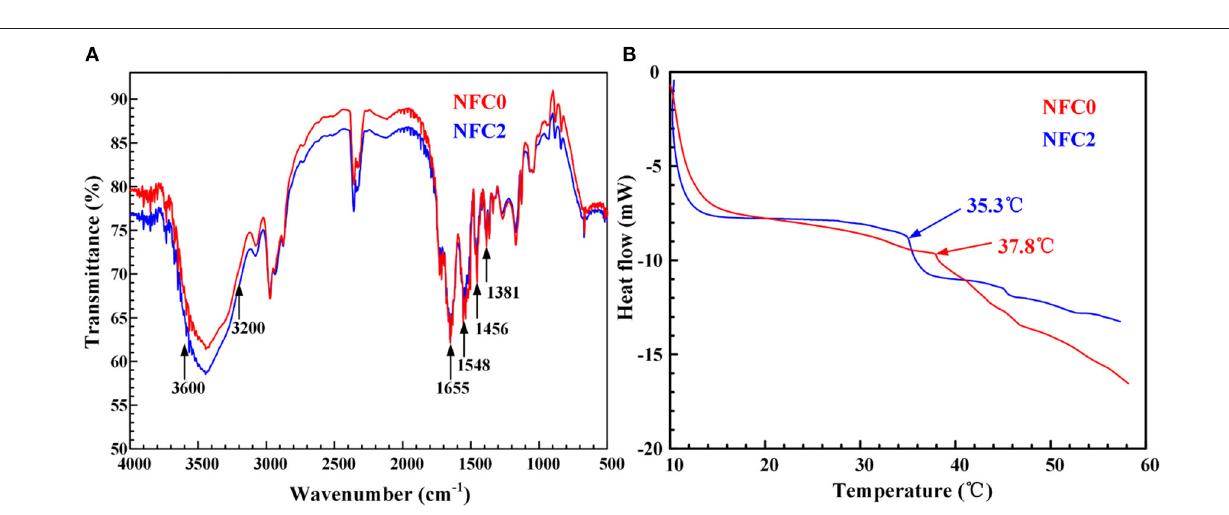
FIGURE 6 | (A) Typical Fourier transform infrared (FTIR) spectra and (B) differential scanning calorimetry (DSC) curves of the NFC0 and NFC2 intelligent